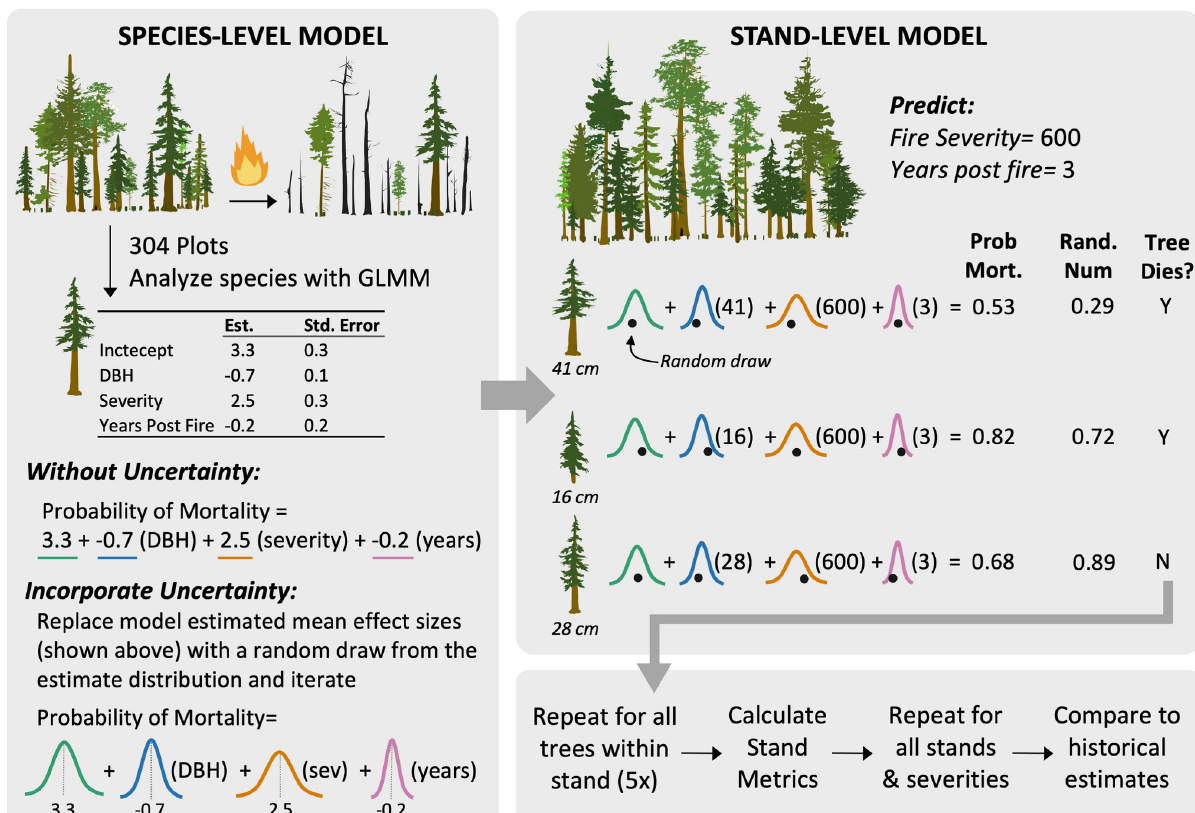
Fig 1. Conceptual diagram depicting simulation procedures. Left panel illustrates the development of a mortality model for one of the 24 individual species modeled and the Monte Carlo simulation framework employed to assess uncertainty in effect size estimates from Generalized Linear Mixed Models (GLMM). Top right panel illustrates application of species-level models to individual trees in contemporary stands (three example trees of the same species with different diameters displayed) within a Monte Carlo simulation framework. Probability of mortality for individual trees was calculated by replacing effect size point estimates with random values drawn from a normal distribution where the mean is the parameter estimate and the standard deviation is the standard error of the parameter from the GLMM equation. Estimates were then inverse logit transformed. This probability was compared to a random value generated from a uniform distribution between 0 and 1. If the randomly generated number was lower than the probability of mortality the tree was considered dead. The bottom right panel describes the iterative process used to assess stand-level model uncertainty and comparison of model estimates to historical estimates of forest